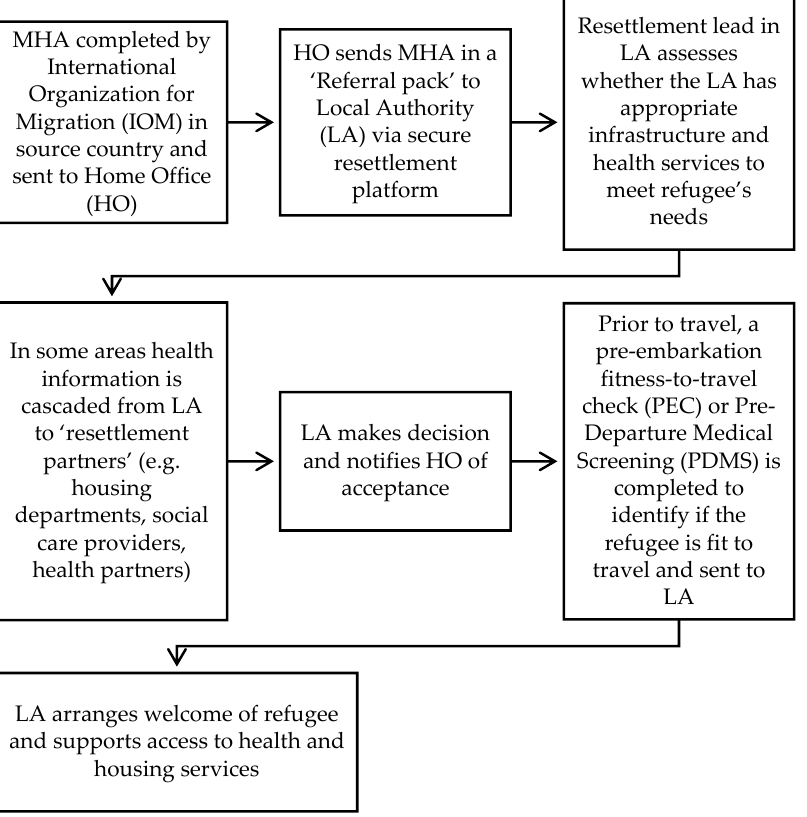
Figure 1. UK Medical Health Assessment (MHA) health information system.